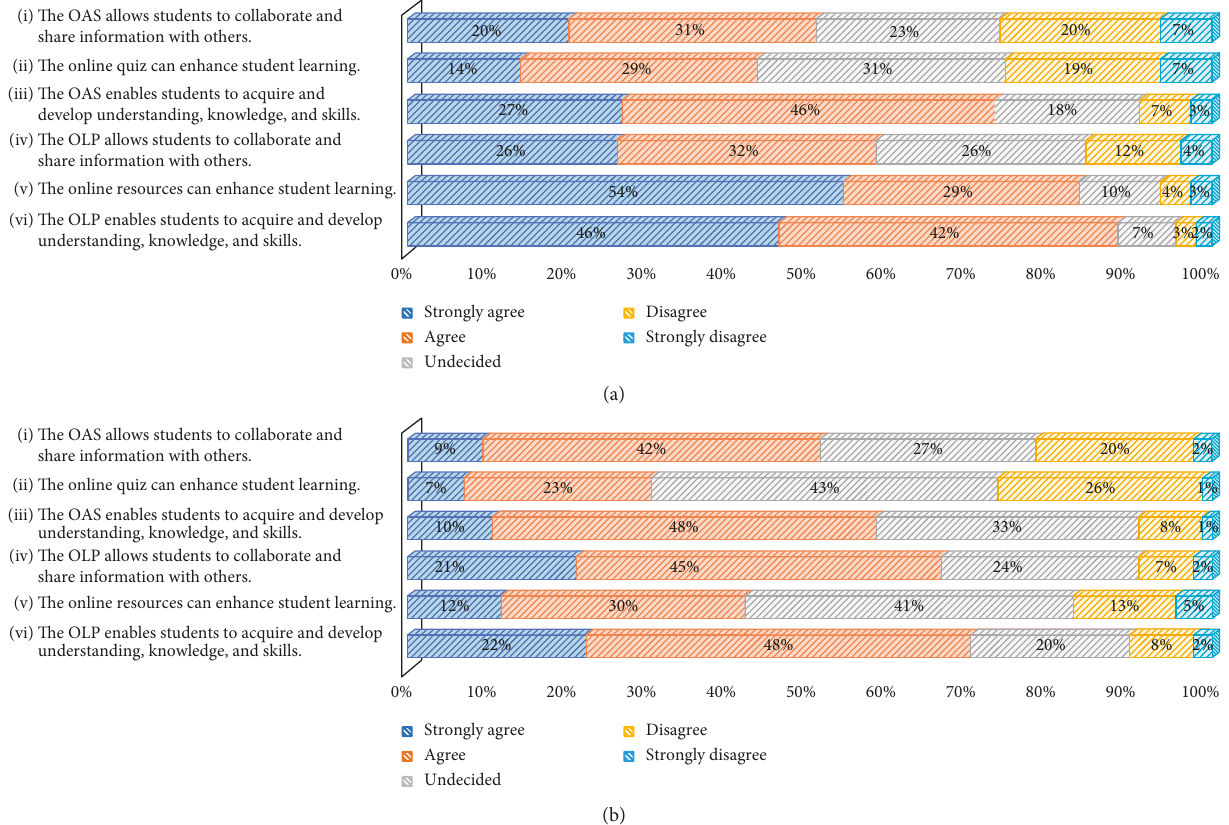
Figure 5: Reflections on the use of online learning platform (OLP) and online assessment system (OAS): (a) CSTstudents’ responses and (b) ELL students’